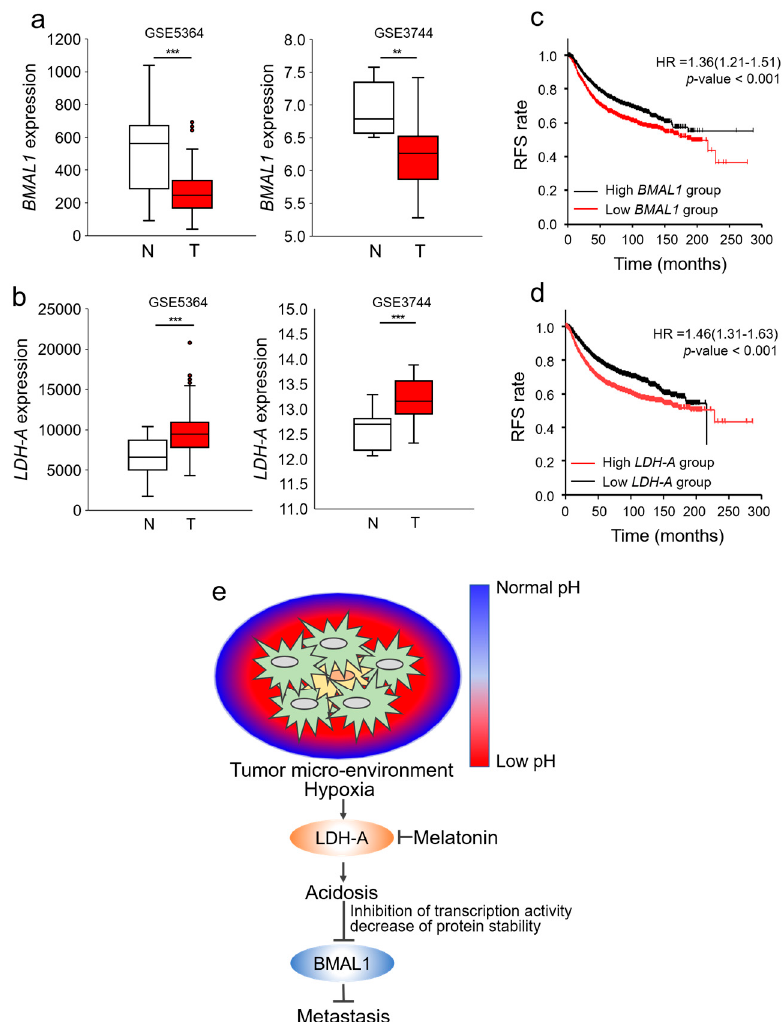
Figure 6. Decrease of BMAL1 is clinically related to poor prognoses in breast cancer patients. ( a , b ) BMAL1 ( a ) and LDH-A ( b ) mRNA expression in normal and cancer breast tissue samples from GSE536 and GSE3744 database sets. N: normal breast tissue T: breast cancer tissue. ( c , d ) Relapse-free survival (RFS) analysis of BMAL1 ( c ) and LDH-A ( d ) low and high breast cancer patients on the Kaplan–Meier plotter database. (p: log-rank, HR: hazard ratio). ( e ) Graphical summarization: tumor acidosis-mediated decrease of BMAL1 via inhibition of transcription activity and protein stability promotes metastatic potency, which could be prevented by melatonin that inhibits hypoxia-induced